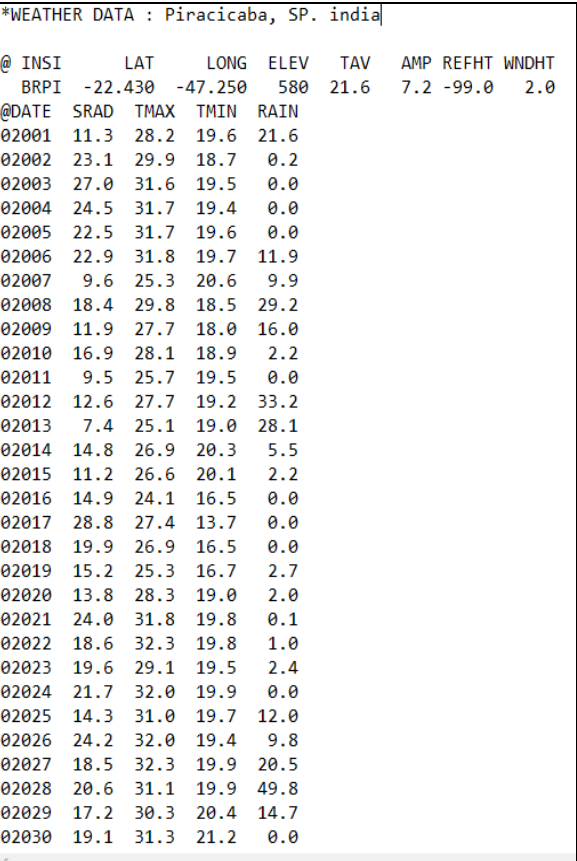
Figure 5. Weather data in DSSAT format